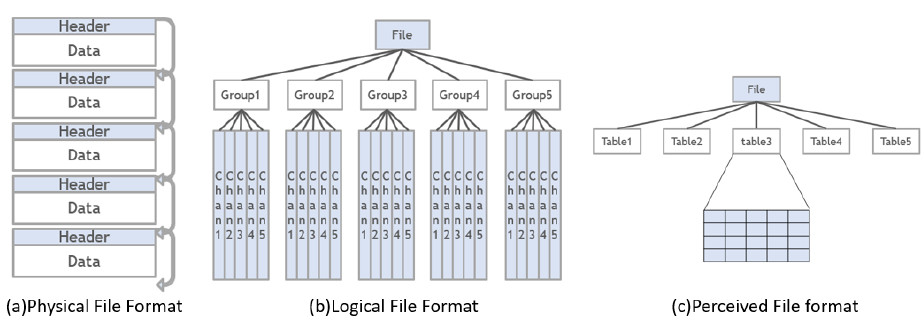
Figure 5. Form of TDMS file.